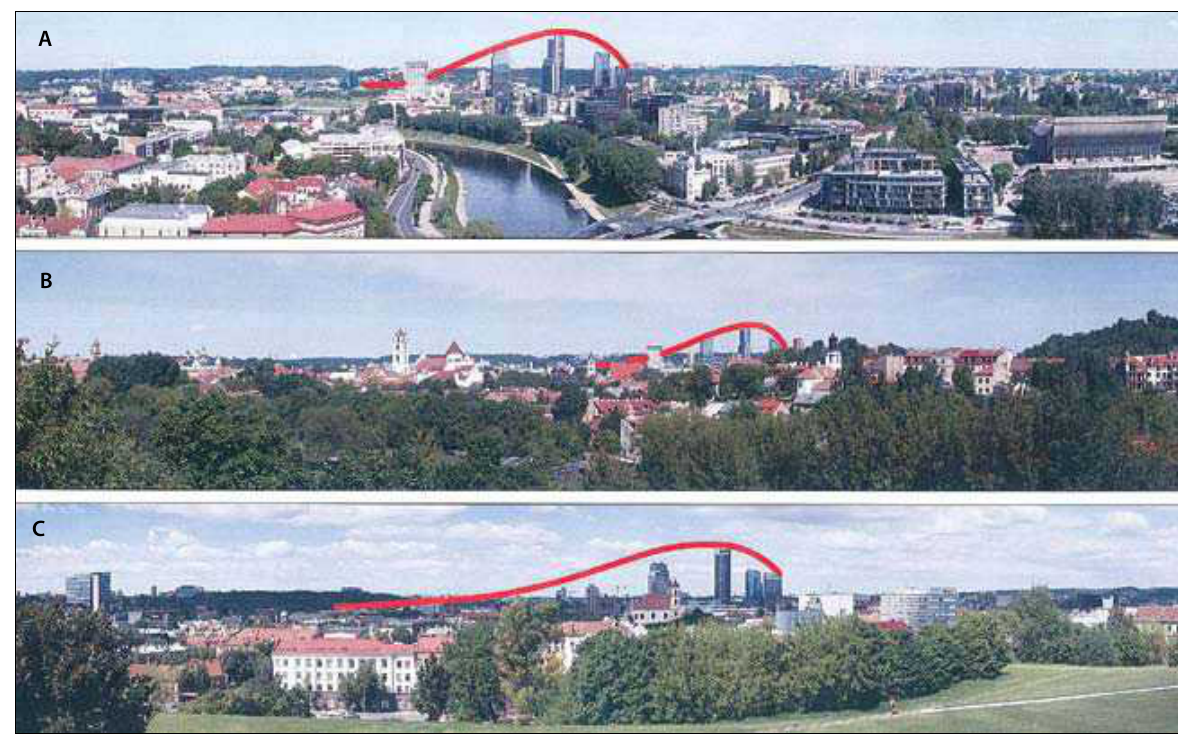
Fig. 5. Selection of visual analysis (a, b,